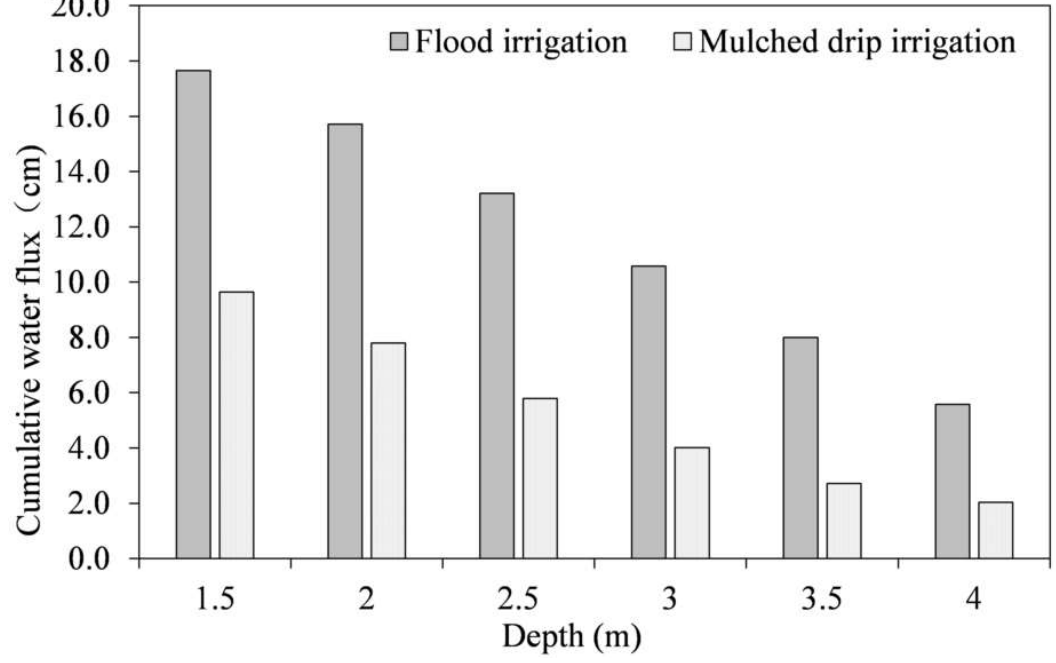
Figure 5. Cumulative water fluxes at different depths under mulched drip irrigation and flood